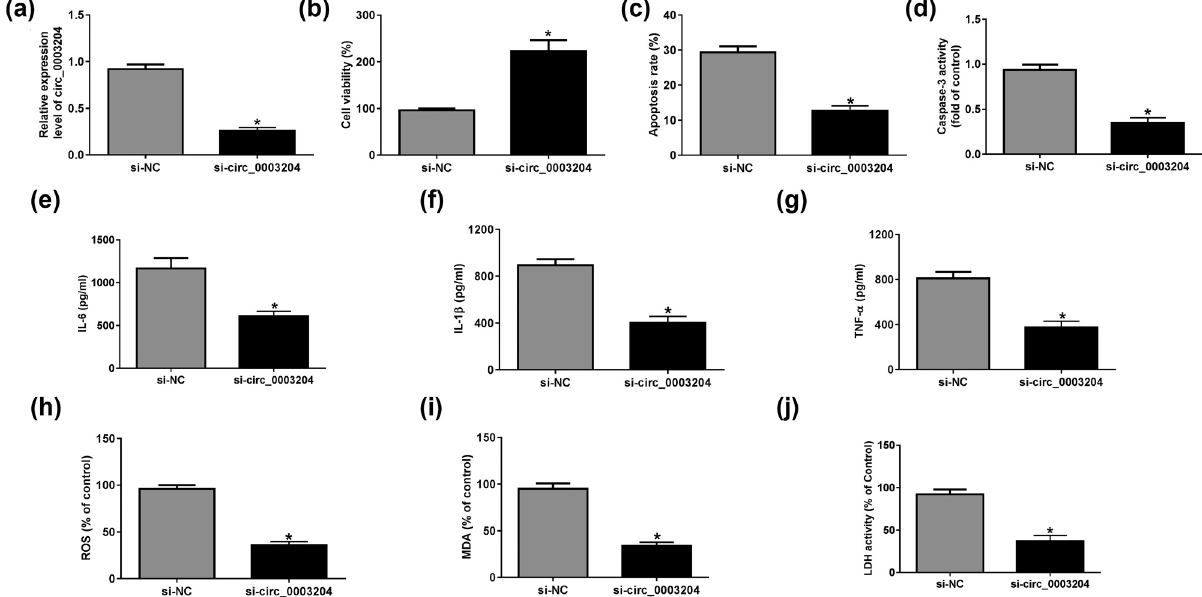
Figure 2: E ff ects of circ_0003204 silencing on ox - LDL - induced HUVECs injury. HUVECs were transfected with si - circ_0003204 or si - NC, followed by treatment with ox - LDL. ( a ) The qPCR was used to detect circ_0003204 expression. ( b ) CCK8 assay was used to determine the viability of HUVECs. ( c ) Flow cytometry was performed to test the apoptosis of HUVECs. ( d ) The activity of caspase - 3 was measured using Caspase - 3 Activity Assay Kit. ( e – g ) IL - 6, IL - 1 β , and TNF - α ELISA Assay Kits were used to assess the contents of IL - 6, IL - 1 β , and TNF - α in ox - LDL - induced HUVECs. ( h – j ) The expression of ROS and MDA and the activity of LDH were evaluated using the ROS, MDA, and LDH Assay Kits, respectively. * P <